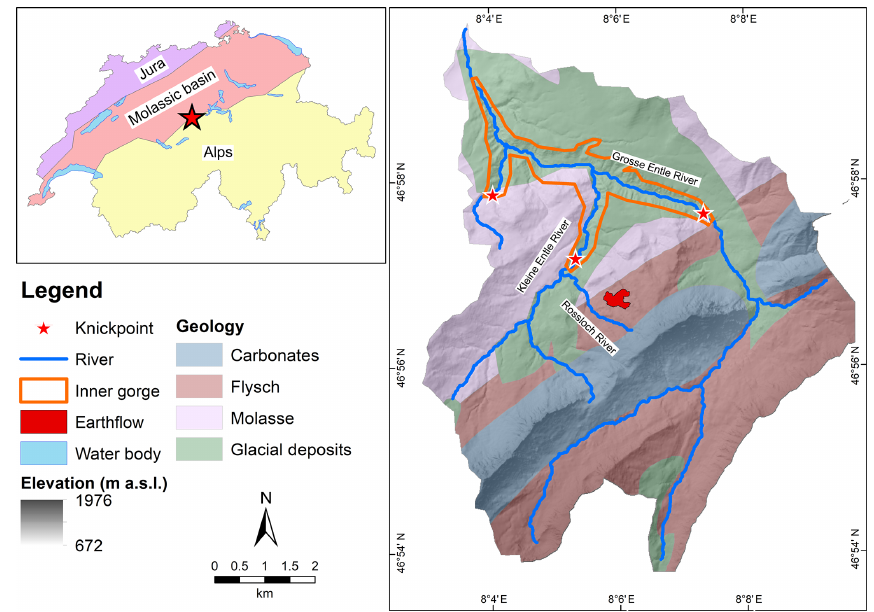
Figure 2. Simplified geological and geomorphological settings of the Entle River catchment (after Van den Berg et al., 2012; Schlunegger et al., 2016a). Inset: location of the study area in Switzerland. Source of the DEM: Swiss Federal Office of Topography Swisstopo (2013).